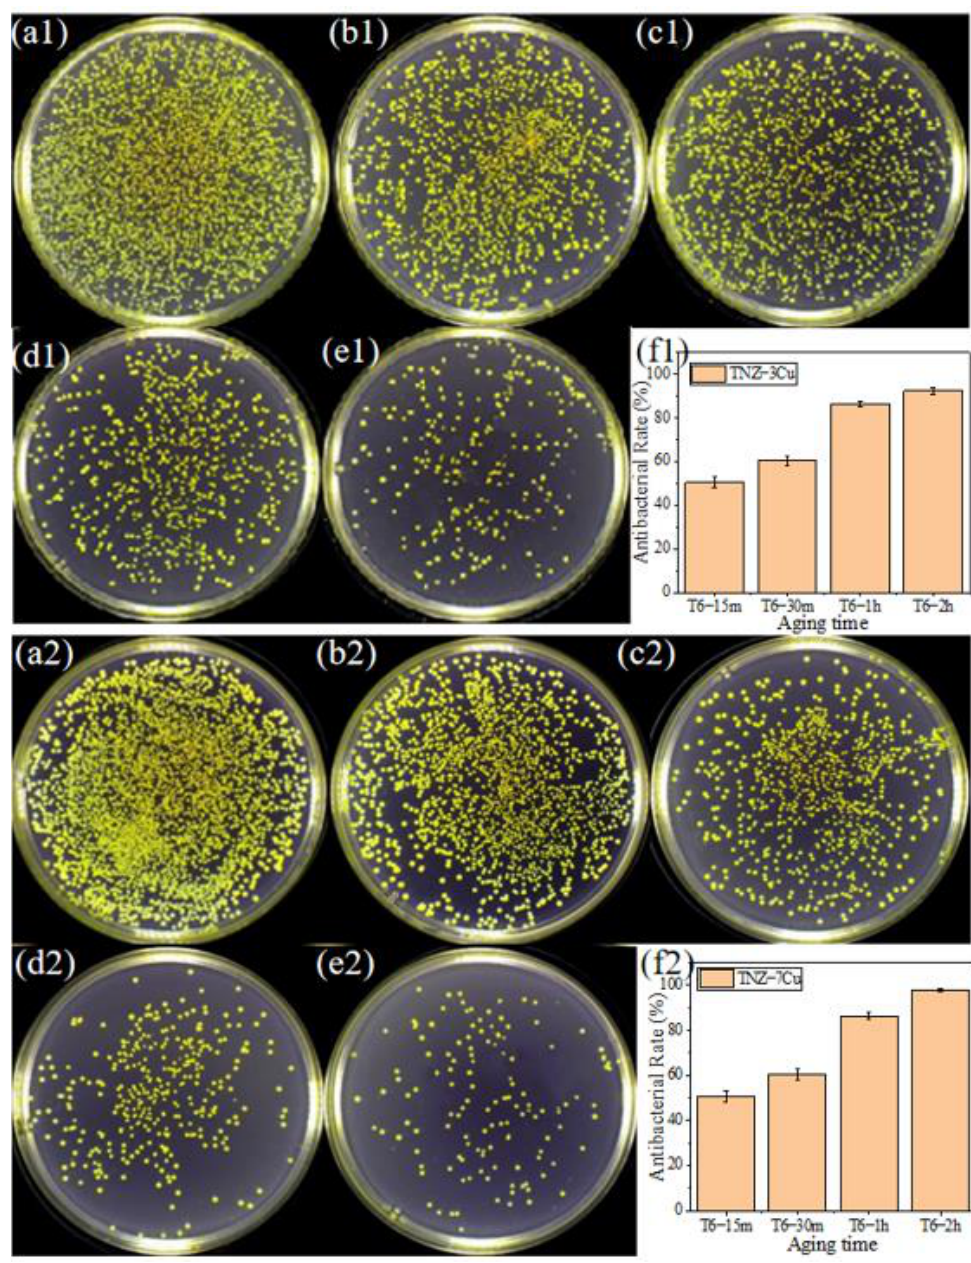
Figure 10. Typical bacteria colony cultured for 24 h on cp-Ti and TNZ-xCu (wt.%, x = 3,7) samples and the antibacterial rate of different aging times. ( a1 , a2 ) cp-Ti; ( b1 , b2 ) T6-15m; ( c1 , c2 ) T6-30m; ( d1 , d2 ) T6-1h; ( e1 , e2 ) T6-2h; ( b1 – e1 )TNZ-3Cu; ( b2 – e2 ) TNZ-7Cu; ( f1 , f2 ): the calculated antibacterial rate of TNZ-3Cu(T6) and TNZ-7Cu(T6).